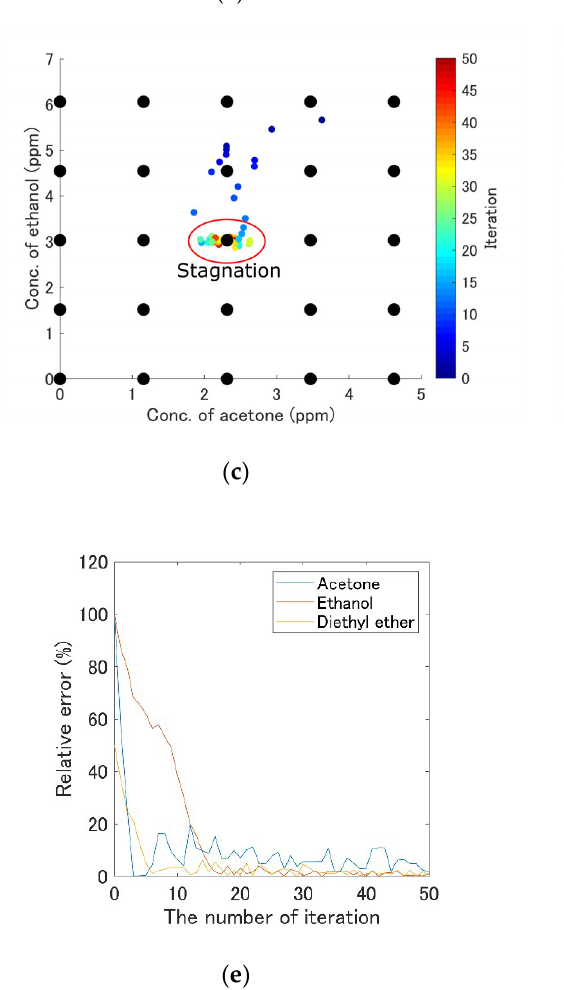
Figure 9. The results of the learning rate auto adjustment. ( a ) 3D view. ( b ) Acetone–ethanol plane. ( c ) Acetone–ethanol plane when the number of iteration increases. ( d ) The update history and the contour map of the error hypersurfaces with fixed concentration of acetone (2.3 ppm). ( e ) The history of relative errors. The initial values of ε init were 1 (acetone), 0.4 (ethanol), and 0.4 (diethyl ether).